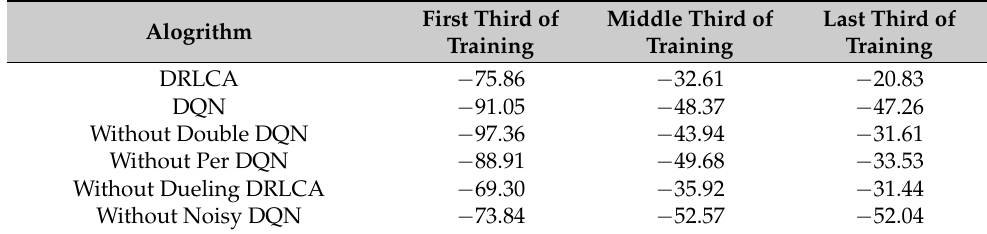
Figure 10. Ablation study. Table 3. Mean of rewards at different stages of ablation